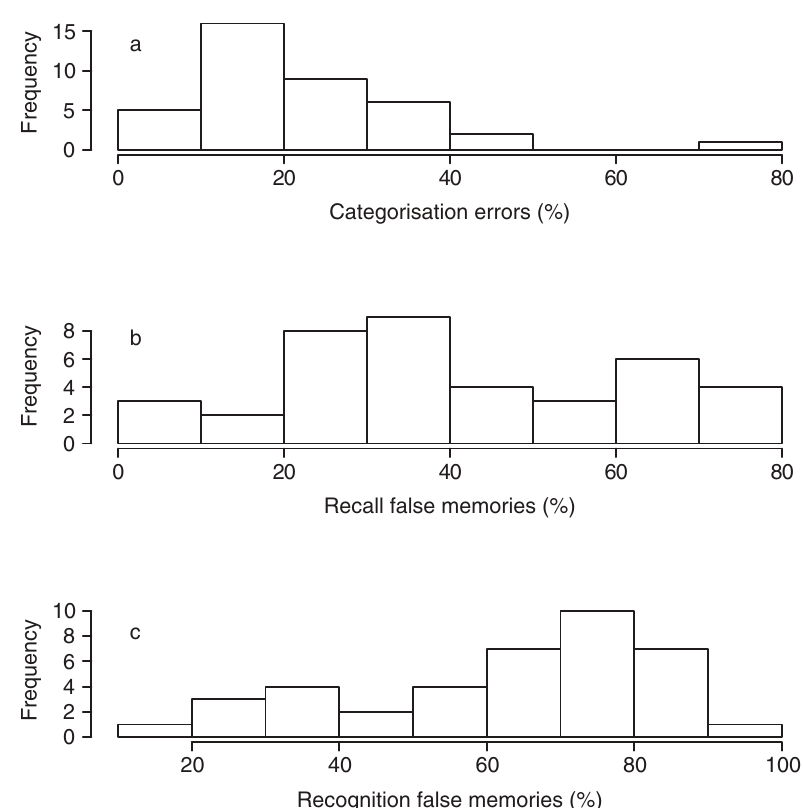
Figure 1. Frequency histograms of individual variation in categorisation ability and false memory performance. a ) the percentage of errors scored by individuals on the categorisation test, b ) the percentage of false memories (out of those possible to elicit) recalled by individuals during the DRM paradigm and c ) the percentage of false memories (out of those possible to elicit) recognised by individuals during the DRM paradigm. N=39. All show a spread of inter-individual